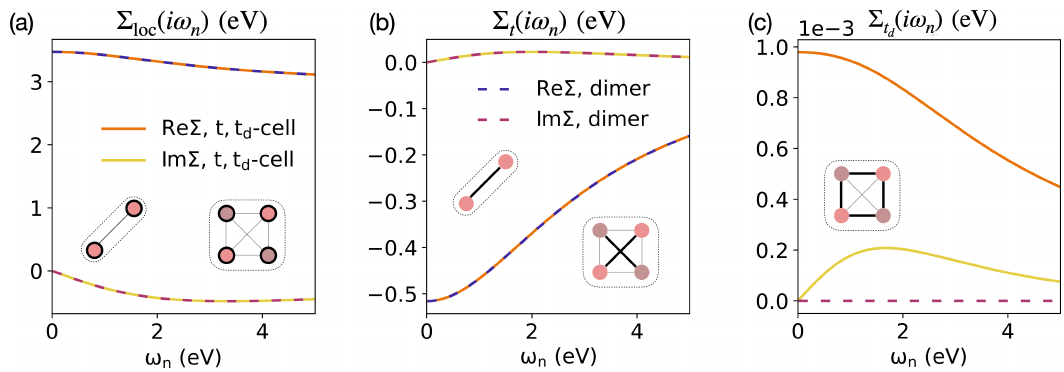
Figure 2: Comparison between selected elements of the self-energy computed on two different clusters using the MPS-based solver on the imaginary axis. Note the difference in scales between panels (a,b) and (c). The components shown belong to the block of the up-spin